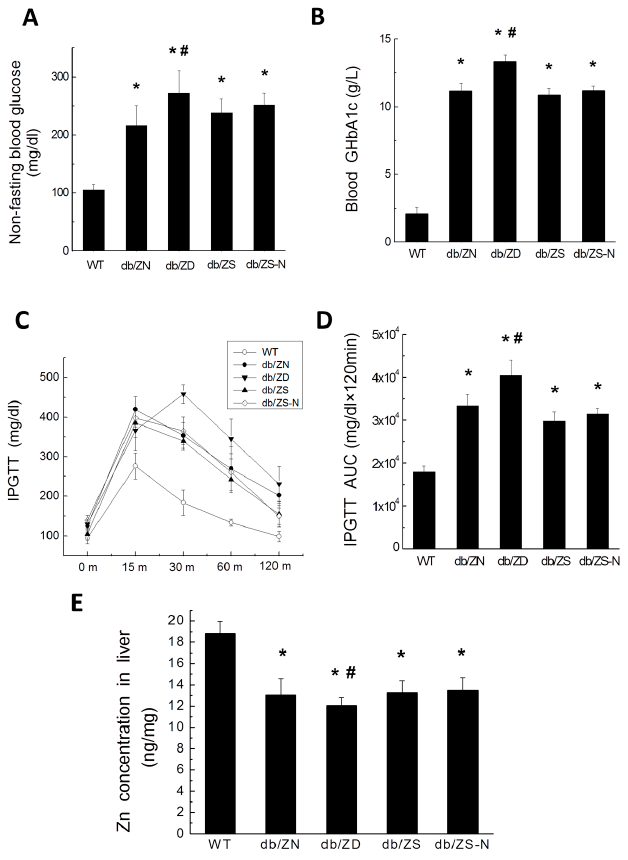
Figure 1. Systemic effects of different Zn amounts in db/db mice. Twenty ‐ one B6.BKS(D) ‐ Leprdb/J mice were randomly divided into four groups and fed normal chow (10% Cal from fat) with different amounts of Zn (ZD, ZN, ZS and ZS ‐ N, respectively); seven C57BL/6J mice were fed ZN as the control group (WT). All mice were fed from the age of 17 weeks, and sacrificed six months later (as 6M). Non ‐ fasting glucose levels ( A ) and blood GHbA1c (g/L) ( B ) were evaluated. IPGTT ( C ) at six months and related area under curve (AUC) values ( D ) were assessed. Zn levels in the liver were measured in WT and diabetic mouse groups ( E ). Data were presented as mean ± SD ( n = 7 for WT control and db/db ‐ ZD (db/ZD) groups; n = 6 for db/db ‐ ZN (db/ZN) group; n = 4 for db/db ‐ ZS (db/ZS) and db/db ‐ ZS ‐ N (db/ZS ‐ N) groups). Differences were assessed by ANOVA with Tukey–Kramer post hoc analysis. *, p < 0.05 vs. WT group; #, p < 0.05 vs. db/ZN group.